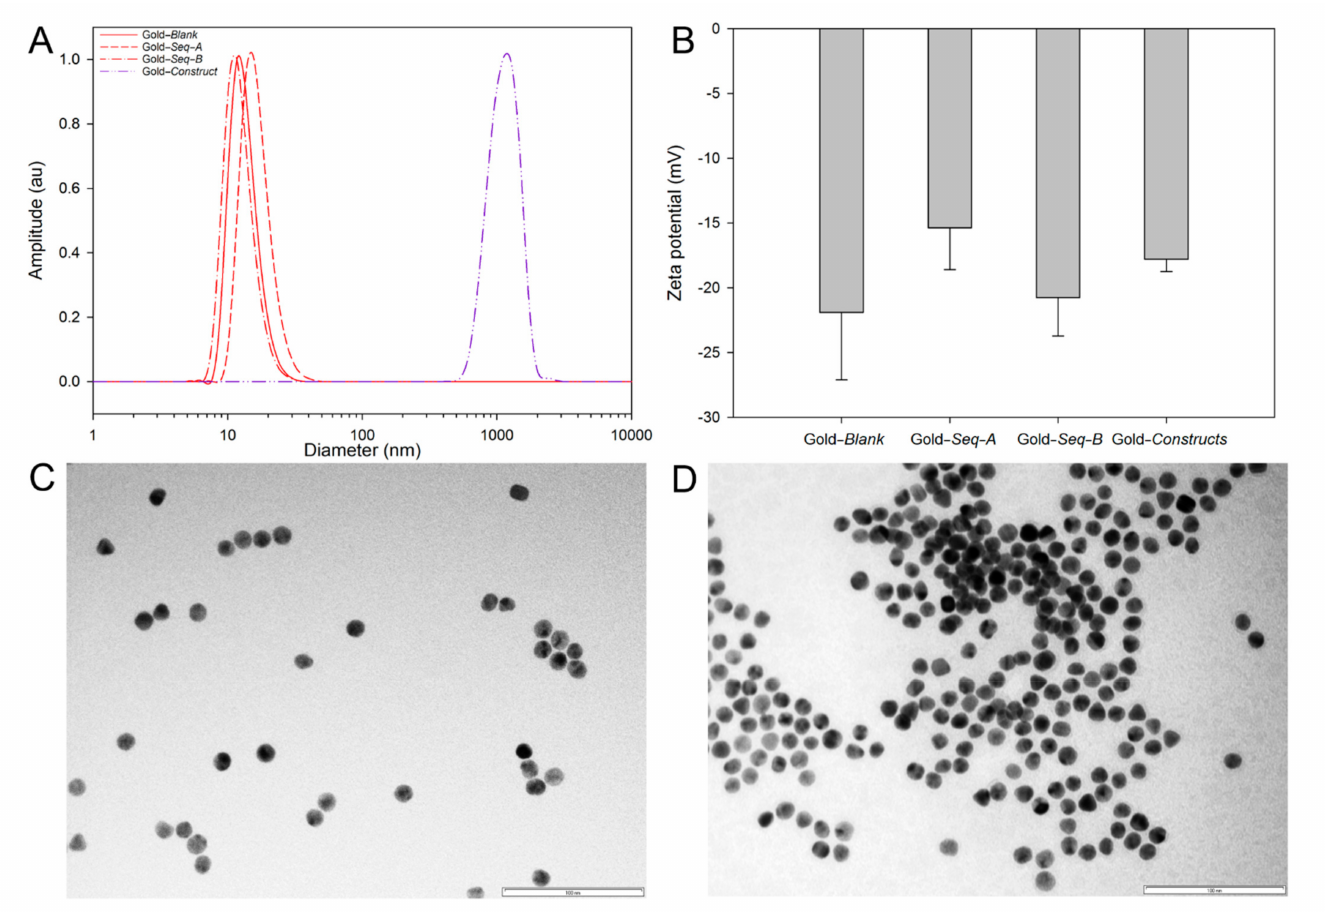
Figure 2. ( A ) Dynamic light scattering-measured mean-centred particle size distribution and ( B ) zeta potential measurements for unfunctionalised gold nanoparticles (Gold– Blank ), gold nanoparticles functionalised with Sequence–A (Gold– Seq–A ) and Sequence-B (Gold– Seq–B ), and gold–oligonucleotide nanoconstructs (Gold– Constructs ). TEM images for ( C ) unfunctionalised gold nanoparticles and ( D ) gold–oligonucleotide nanoconstructs. Scale bar = 100